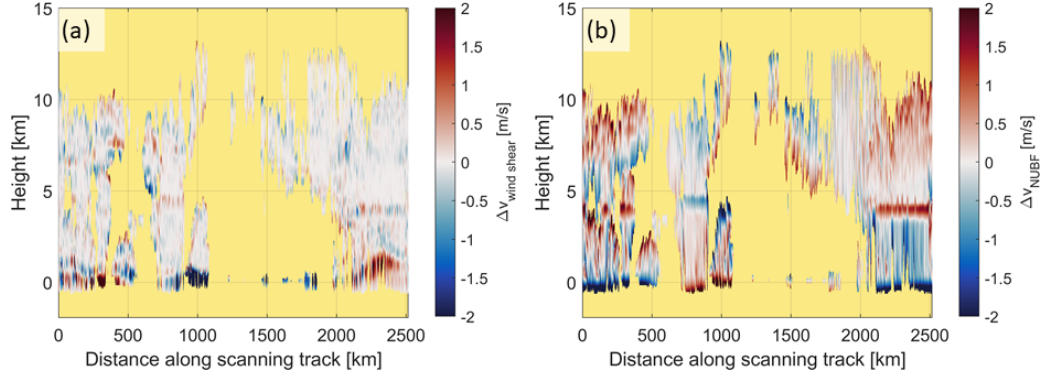
Figure 17. Errors induced by wind shear (a) and NUBF (b) in correspondence to the revolution shown in Fig. 9b. After corrections for beam filling using the vertical gradient of Z derived from the WIVERN data itself, these errors are expected to reduce to less than 1ms − 1 .